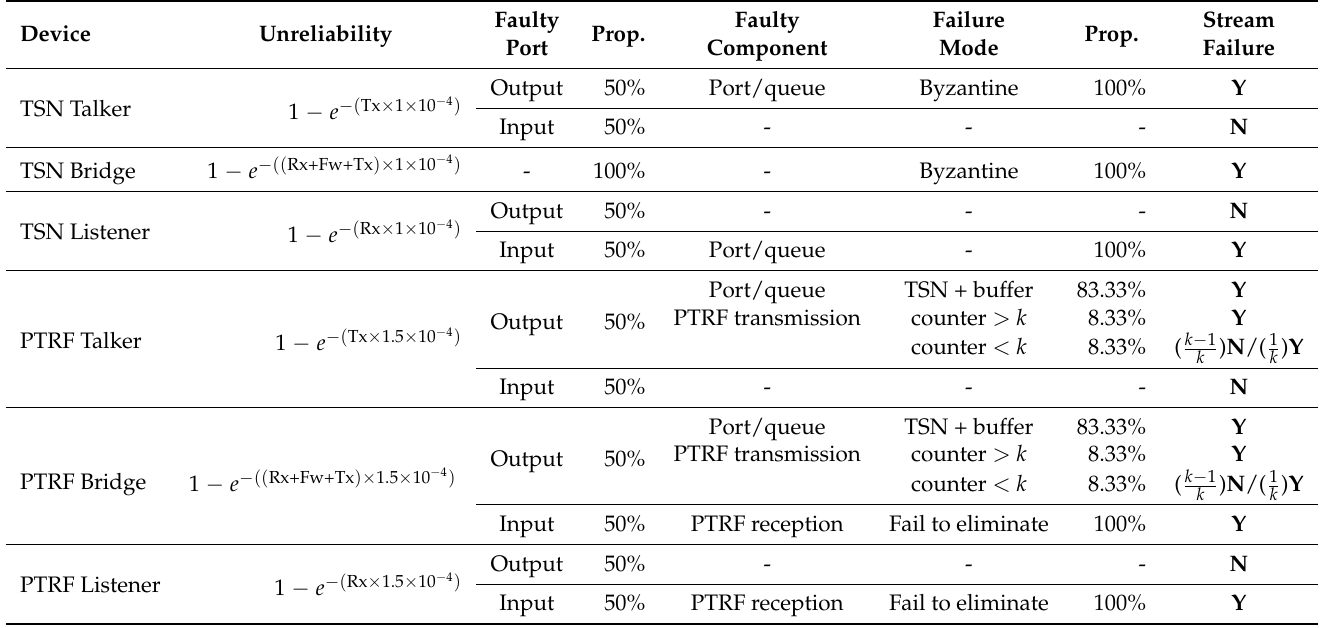
Table 1. Unreliability of each device, failure mode proportions and their impact on the